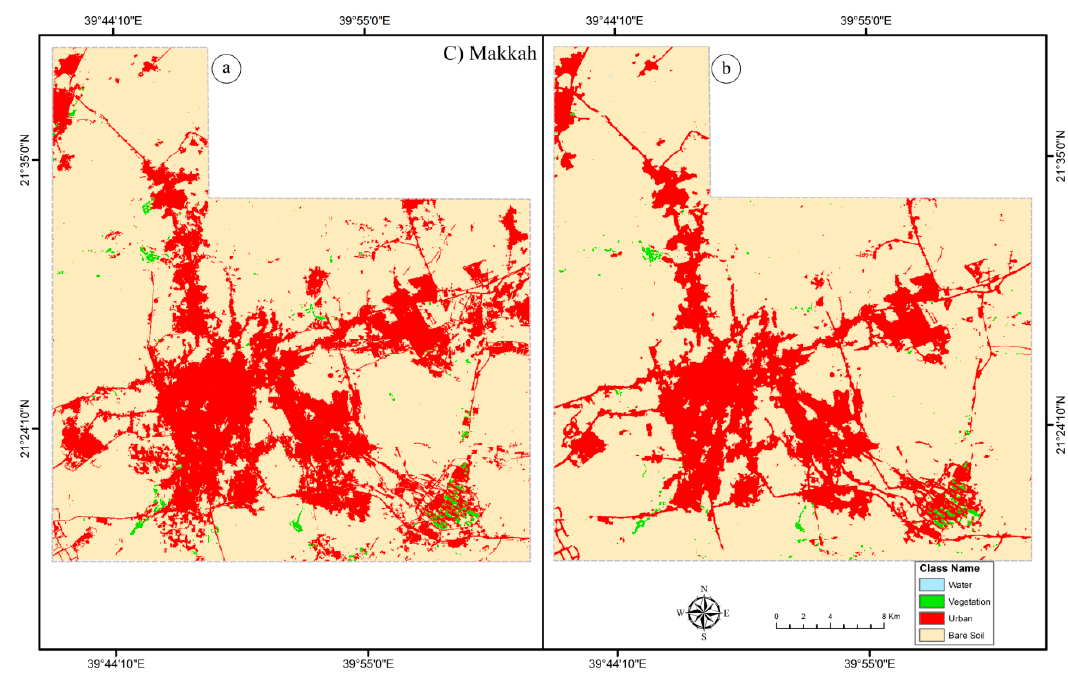
Figure 6. A comparison between the reference LULC change map ( a ) and the simulation map of LULC changes ( b ) in 2014 for ( A ) Riyadh; ( B ) Jeddah; ( C ) Makkah.